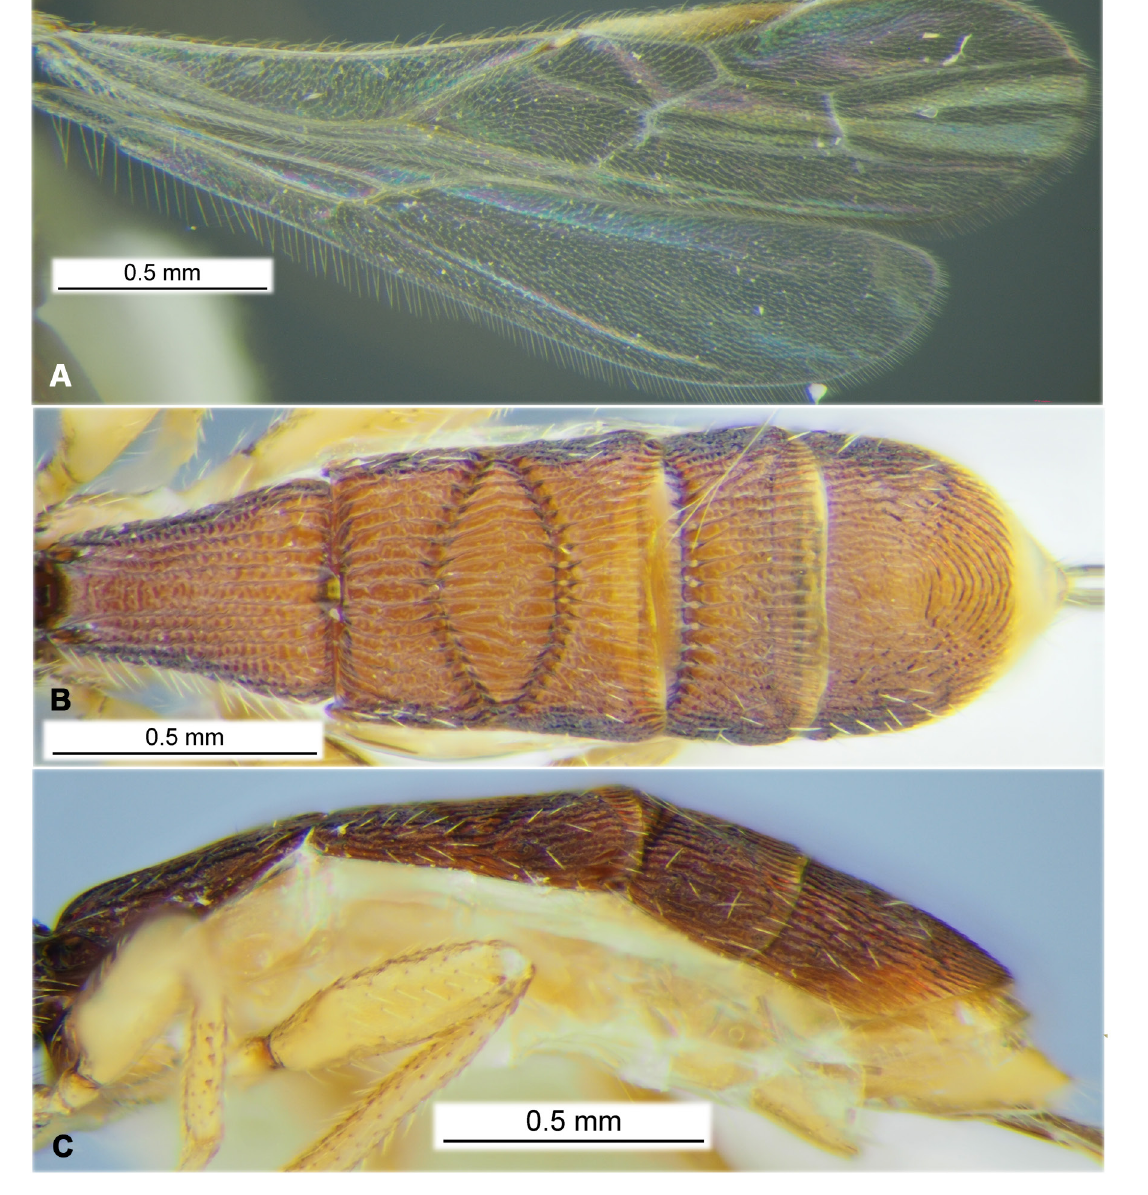
Fig. 52. Rhaconotus ( Rh. ) magniareolus Belokobylskij sp. nov., holotype, ♀ (RMNH). A . Wings. B . Metasoma, dorsal view. C . Metasoma, lateral